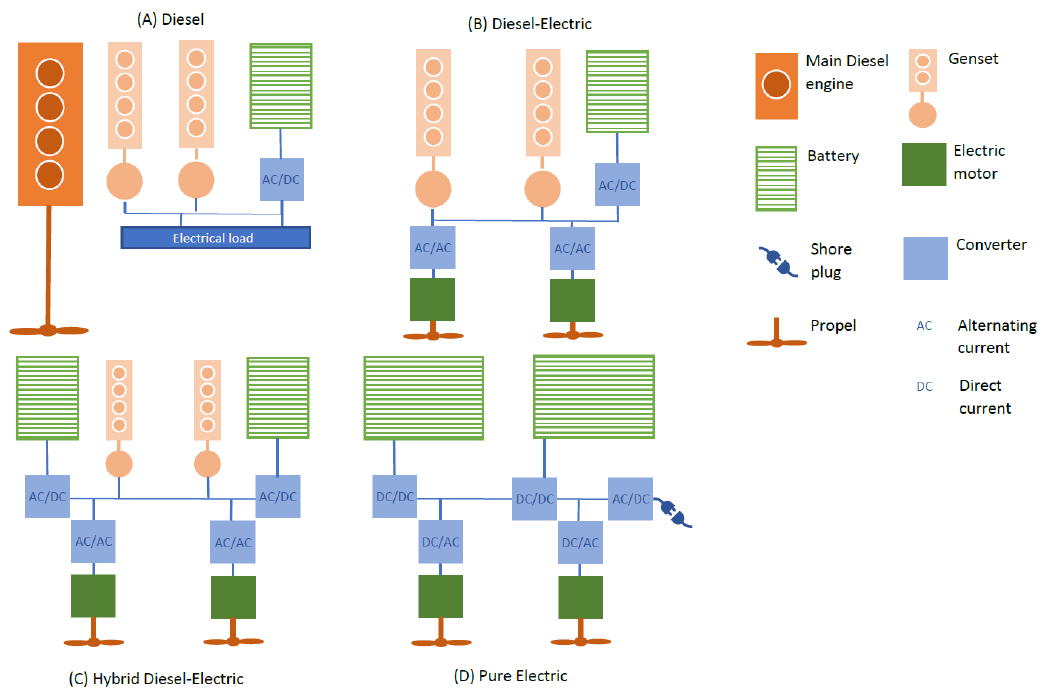
Figure 1. Basic mechanical, hybrid, and pure electric vessel propulsion systems based on electrochemical energy sources.